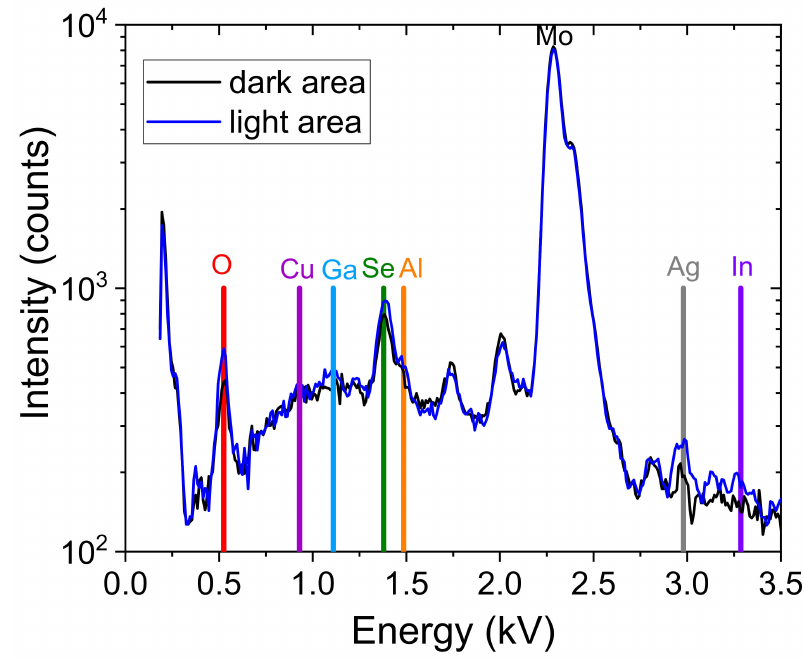
Figure A2. EDS spectra of the Mo back contact with the assigned peak positions: Al, Ag, In and Se. Also shown are O, Ga, Cu and